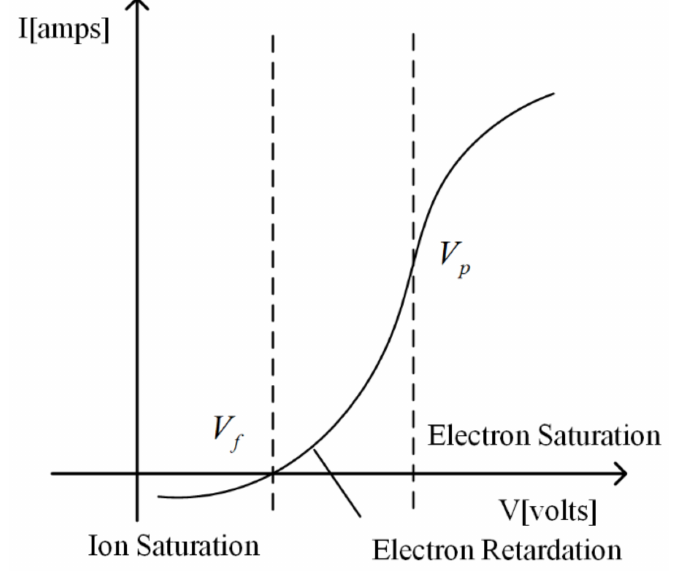
Figure 1. A representative I–V characteristic